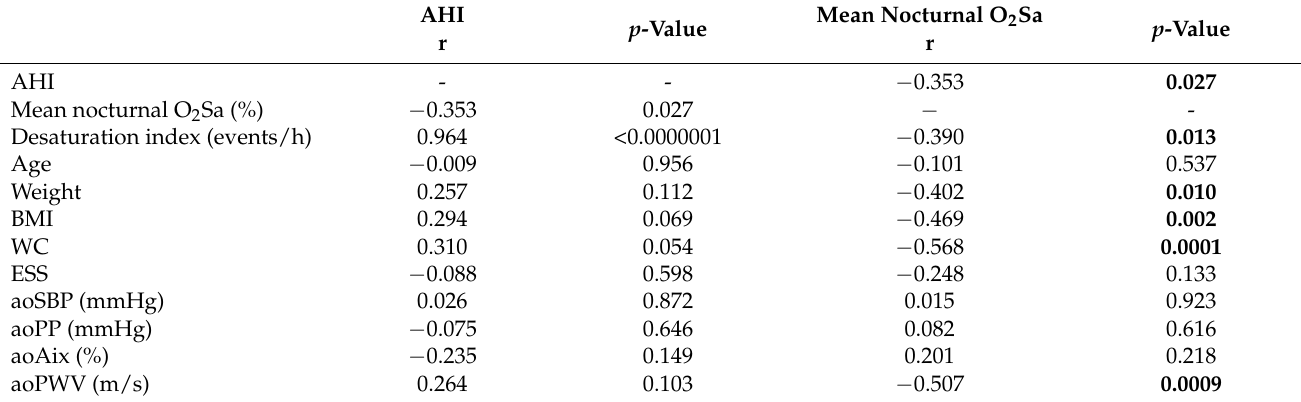
Table 3. Correlations between OSA parameters with demographic and arterial stiffness parameters ( n =